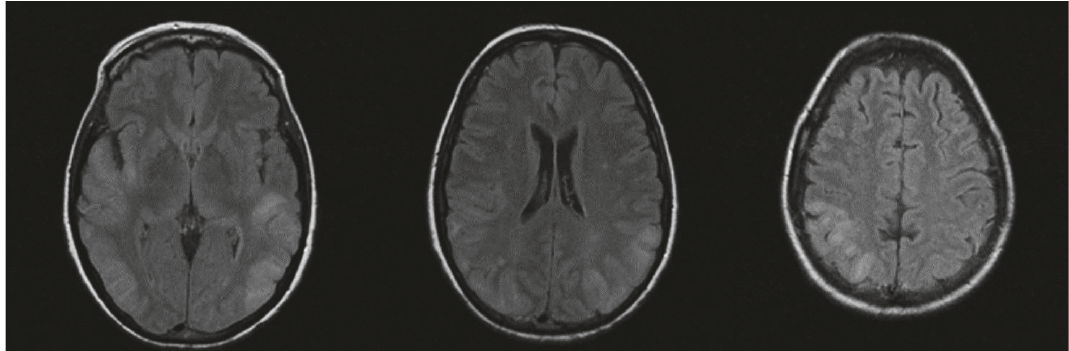
Figure 3: Case No. 2. Flair sequences showing alterations of signal in the white matter and cortex of the right temporal lobe and in both parietal and occipital